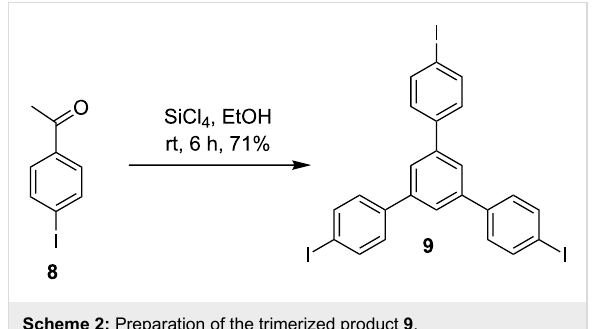
Scheme 2: Preparation of the trimerized product 9